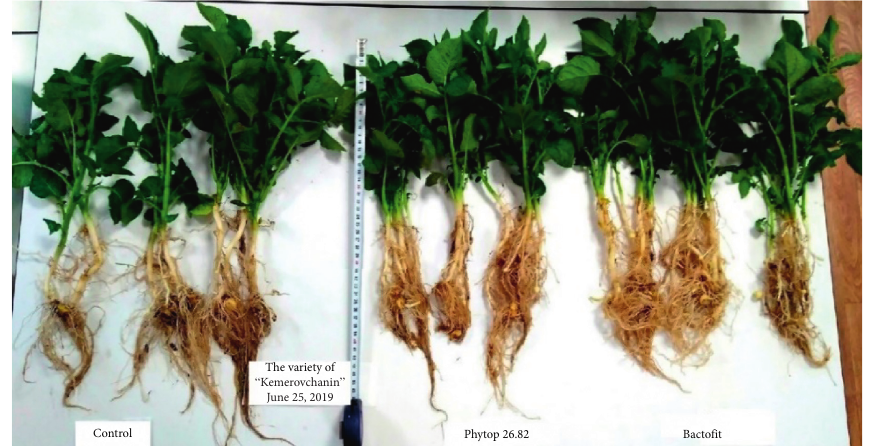
Figure 3: The stems of the “Kemerovchanin” potato variety at the 4th counting week according to three variants (control, Phytop 26.82, and Bactofit). As we can see in the photo, the most extended potato stem is 46cm (the branch of the biological product Phytop